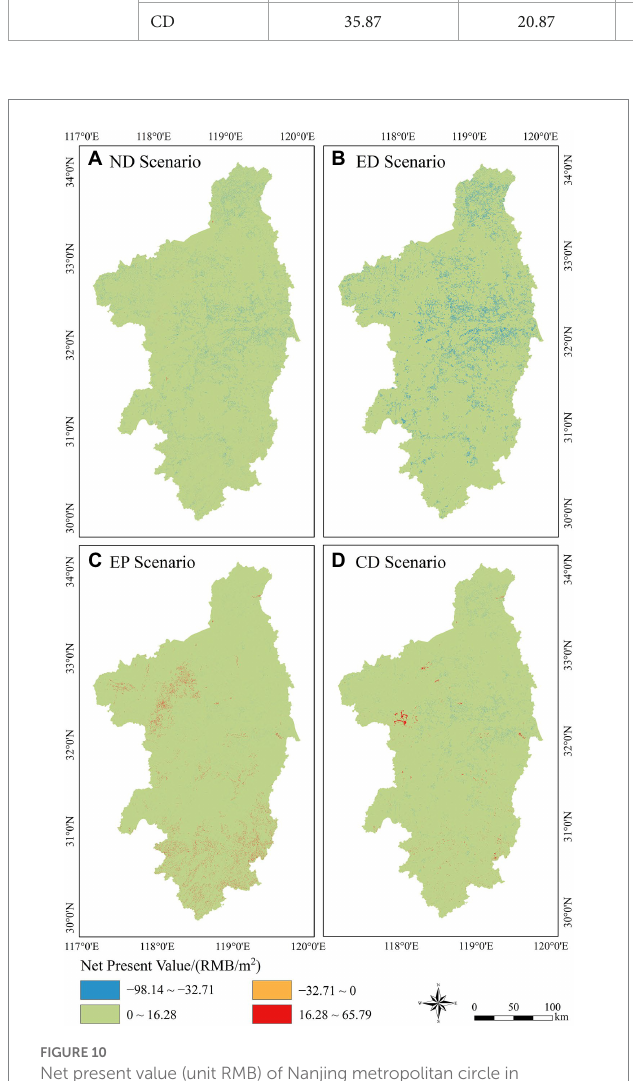
FIGURE 10 Net present value (unit RMB) of Nanjing metropolitan circle in 2020–2030 under four scenarios: (A) ND; (B) ED; (C) EP; and (D)